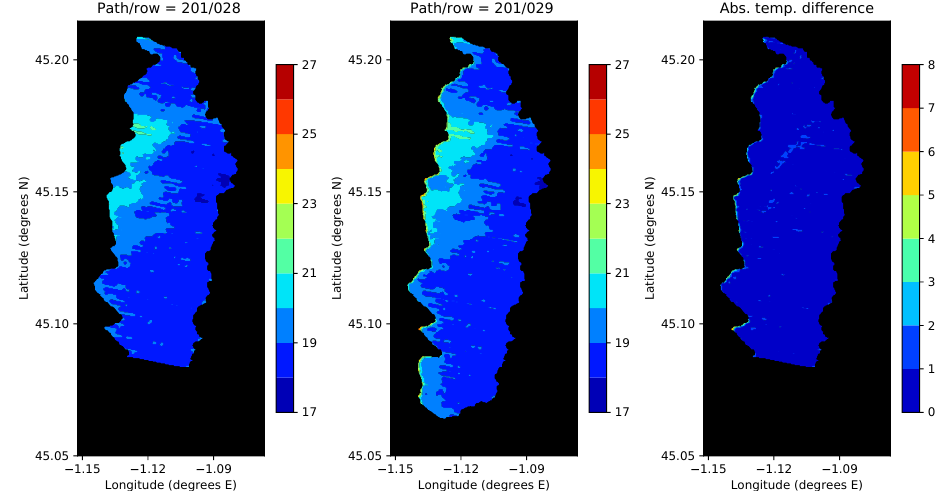
Figure 10. Water temperature according to two overlapping images for the Étang de Carcans-Hourtin (ECH33) on 7 April 2011, and absolute temperature difference between both images. Table 2. List of pairs of overlapping satellite images with temperature differences higher than 3 ◦ C. Date Satellite Path/Row Water